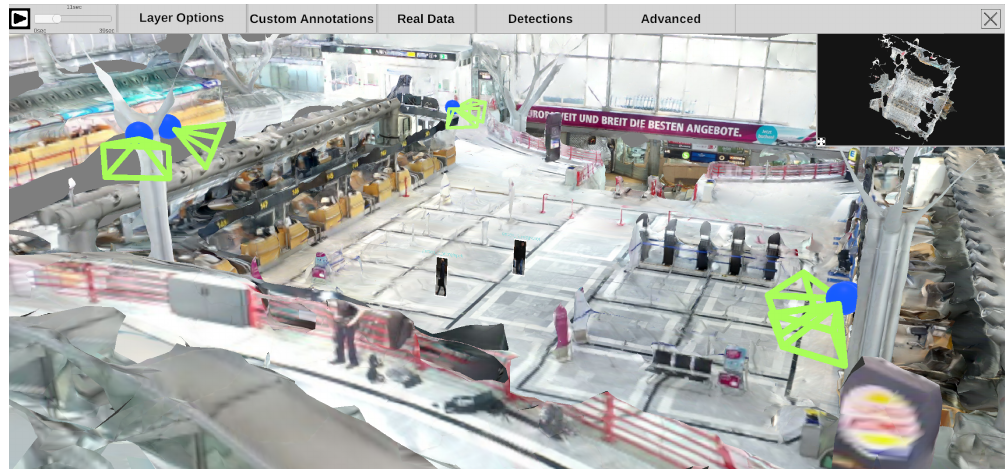
Figure 31. Reconstruction of airport in which multiple surveillance cameras are spatially registered. Video streams of the cameras are fed into the system and automatically extracted detections are depicted in the 3D reconstruction in